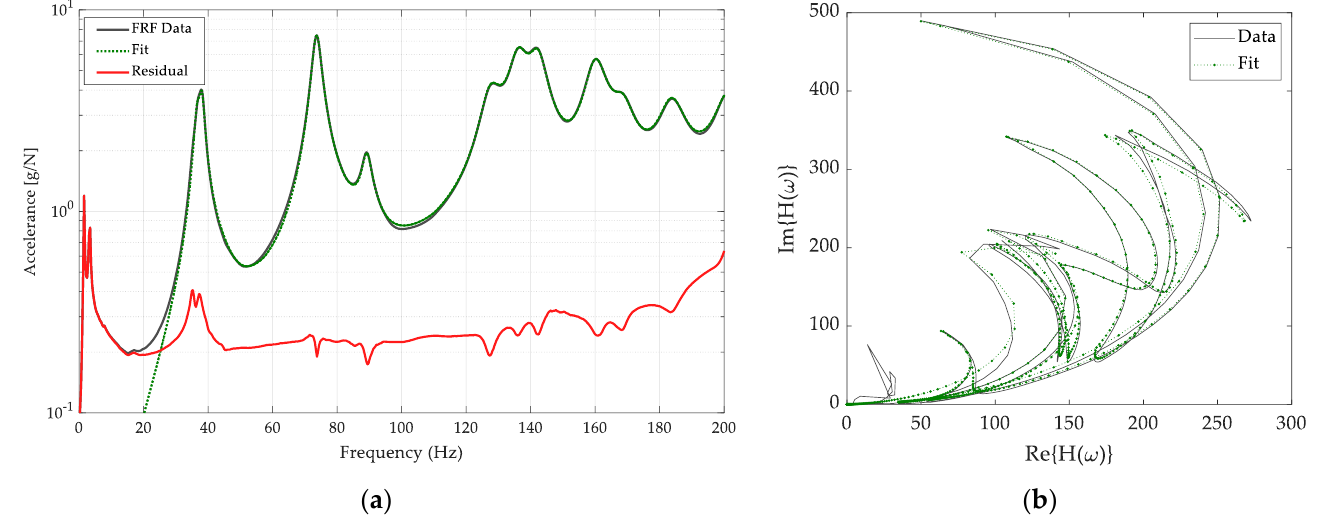
Figure 21. ( a ) Compact panel FRFs. The dark gray line indicates experimental FRF data, the green dotted line represents the AMI fit and the red line shows the residual (error) after refinement of a multi-mode model fit. ( b ) Complex plane plot of composite. H(w) is the FRF. The composite FRF for the compact and the foamed door panels is shown in Figure 22.